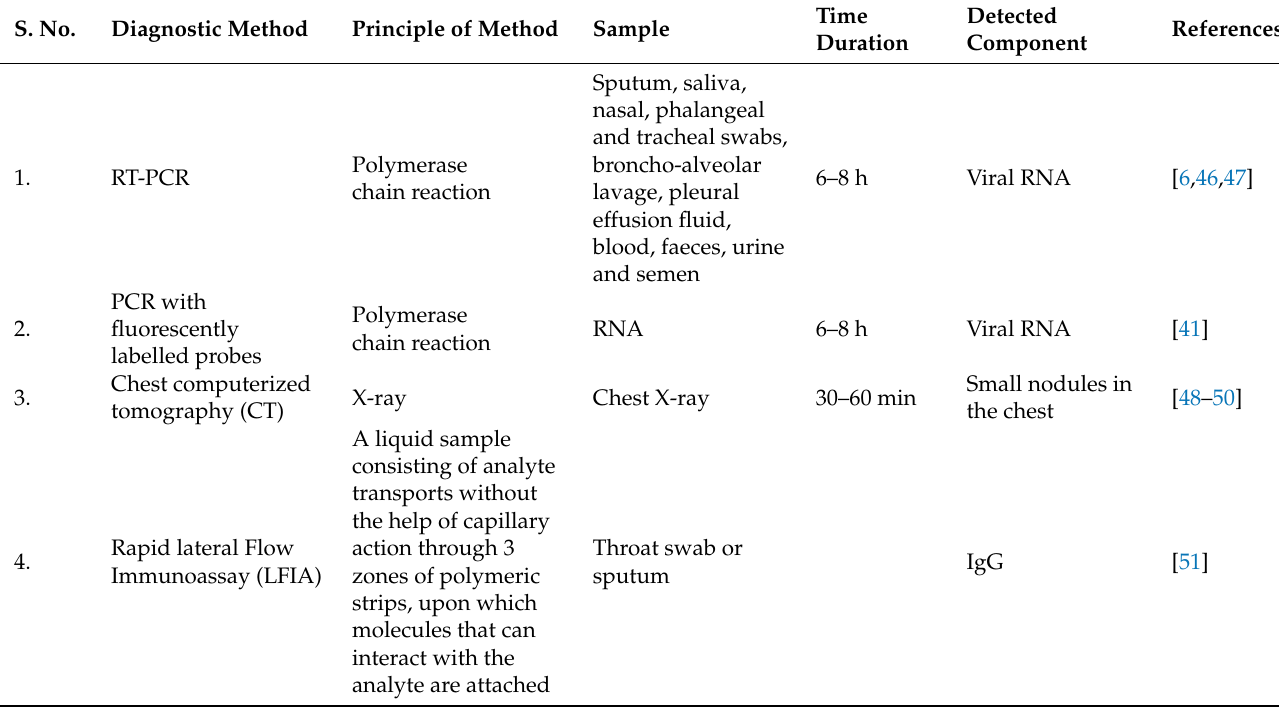
Table 2. Diagnostic tests for SARS-CoV-2